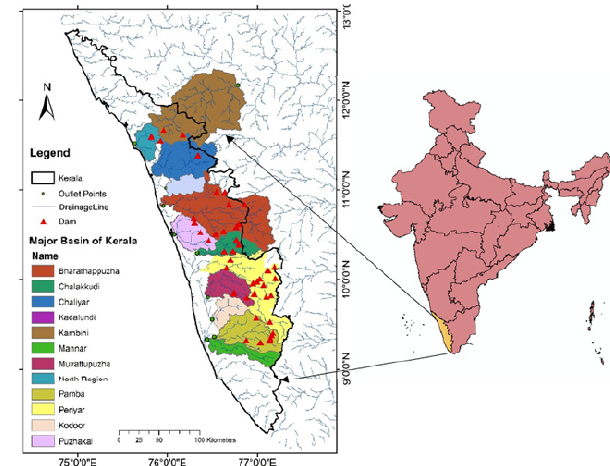
Figure 2. Major river basins of Kerala as delineated using ALOS-30 m DEM.